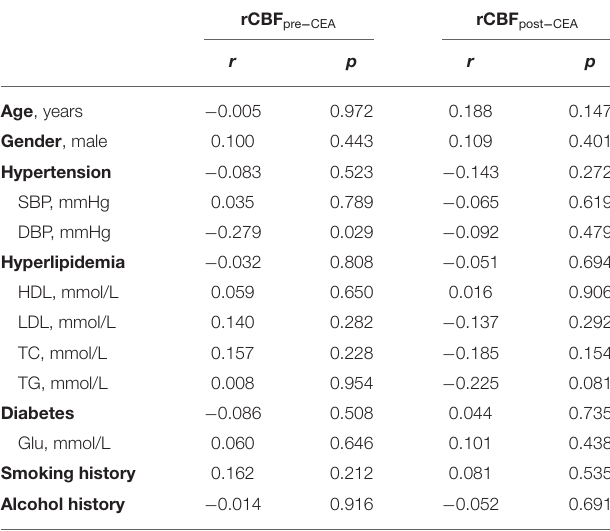
TABLE 3 | Correlations between clinical information and CBF ( n =